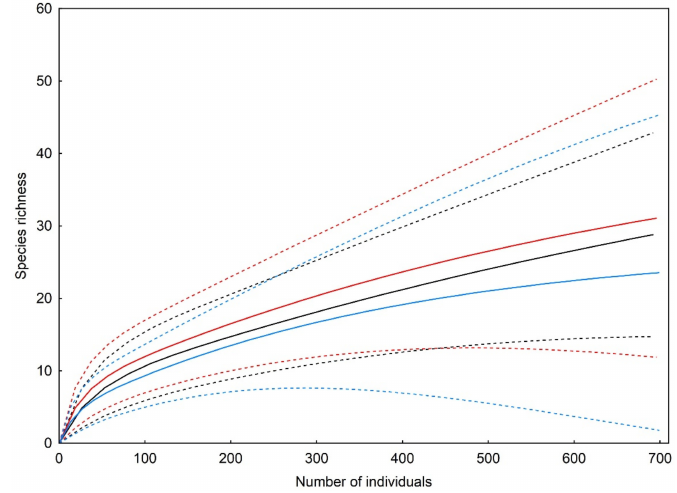
Figure 1. Individual-based rarefaction (solid) curves with 95% confidence limits (dashed curves) compar- ing species richness of branch-dwelling spider assemblages in three developmental phases of primeval oak–lime–hornbeam forest: the optimal phase (black), terminal phase (red) and regeneration phase (blue). The highest species diversity of spider assemblages from tree branches was found in the terminal phase (H (cid:48) = 2.01), followed by the optimal phase (H (cid:48) = 1.91) and the regeneration phase of the forest stand development (H (cid:48) = 1.55). The Hutcheson test revealed differences between the optimal phase and the regeneration phase (t 296 = 3.19; p = 0.002), as well as between the terminal phase and the regeneration phase (t 281 = 4.10; p < 0.001), while no differences were found between the optimal phase and the terminal phase (t 438 = 1.08; p = 0.283).